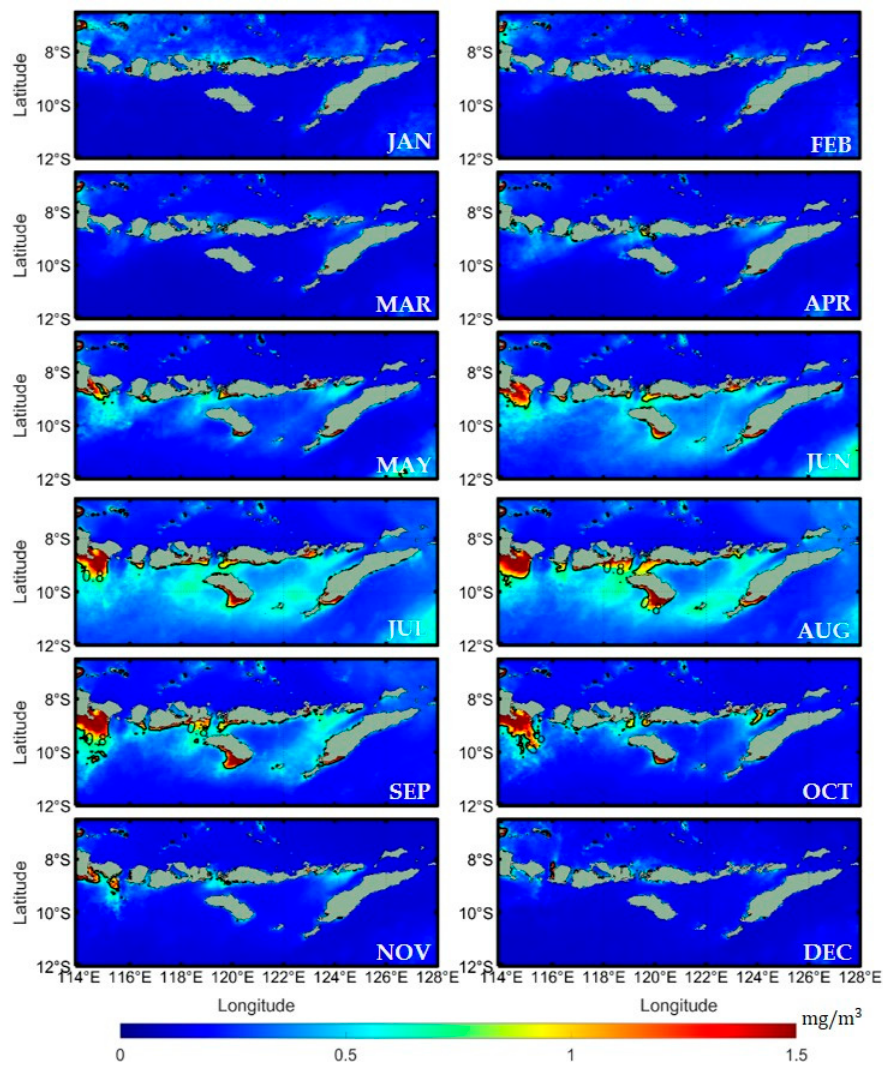
Figure 3. The climatological monthly mean values of chlorophyll-a during 2007–2020.